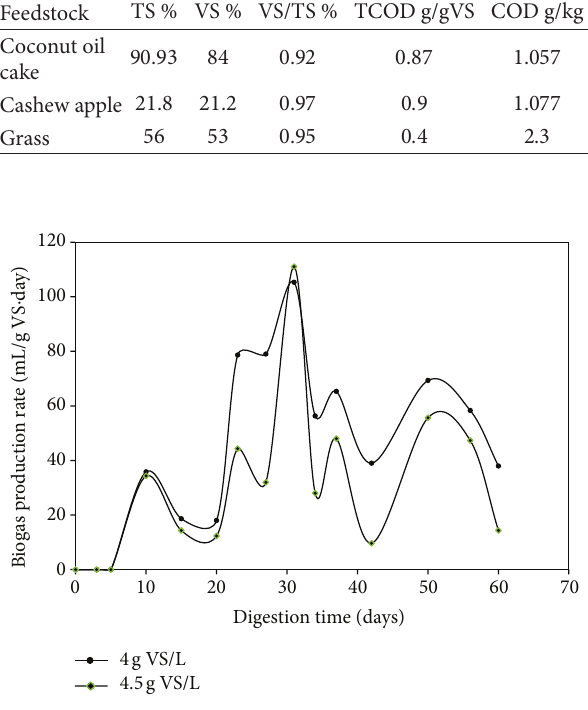
Figure 1: Daily biogas production rates at different volatile solid